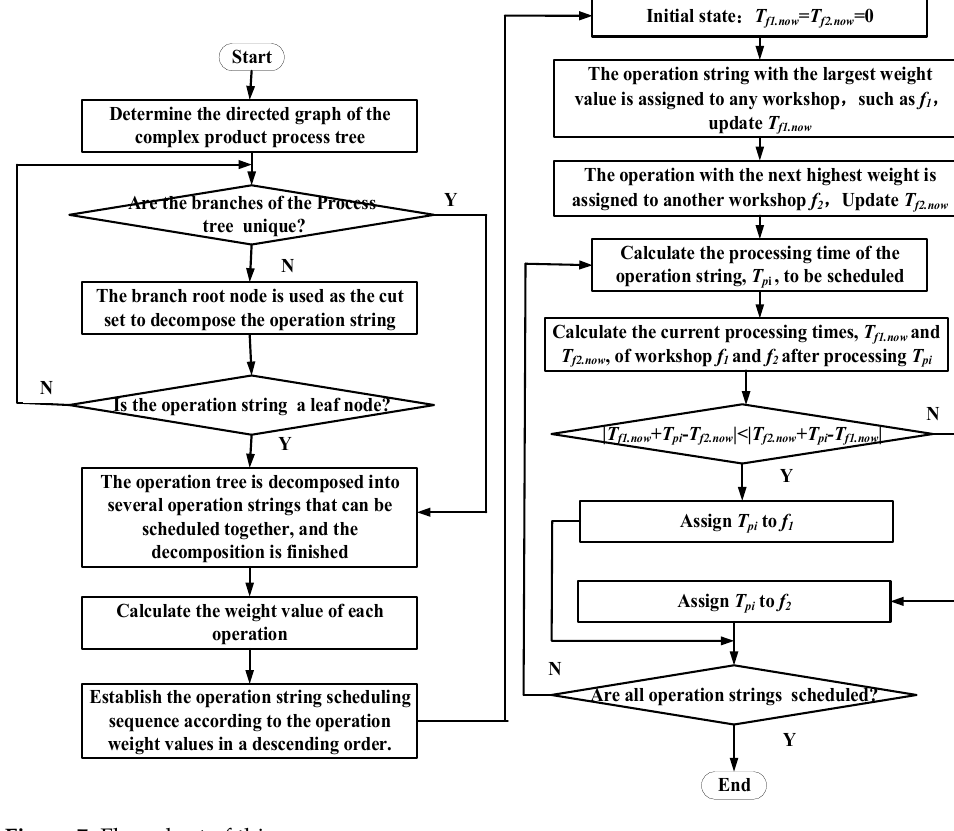
Figure 7. Flow chart of this paper.